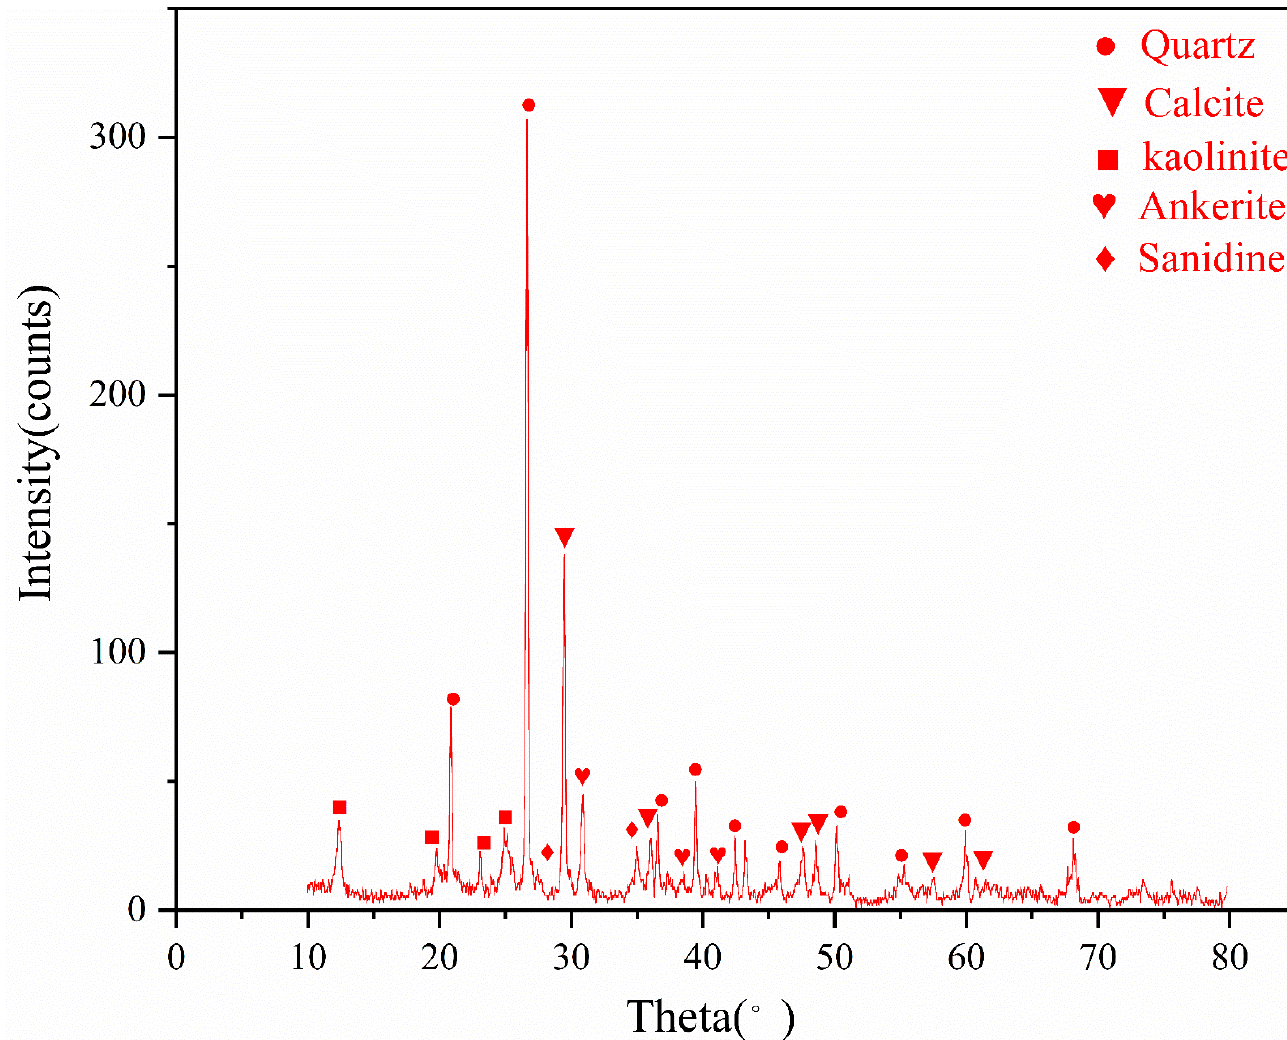
Figure 3. The Mineral XRD analysis results plot. Table 3. Chemical Compositions of the Original Coal Gangue Sample and its Post-Leached